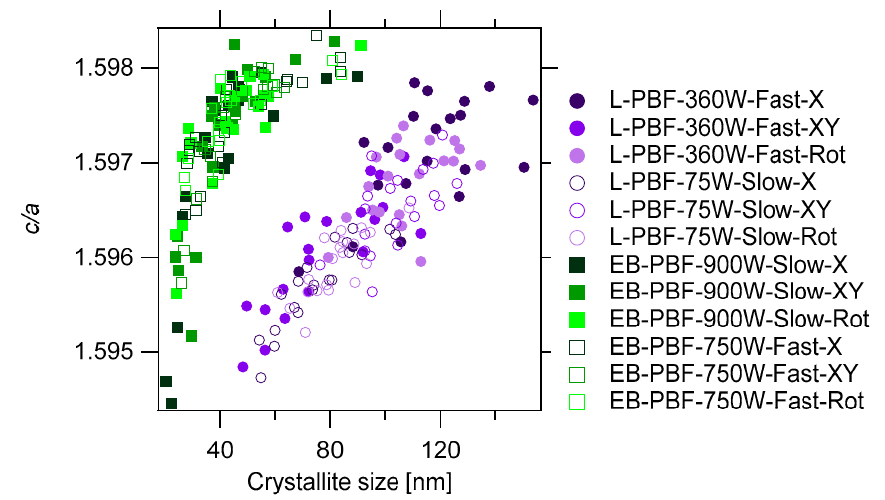
Figure 5. Crystallite size of the α or α ’ phase versus random lattice strain of the α or α ’ phase scatter plots for all L-PBF and EB-PBF parts. Random lattice strain in ( a ) the a -axis and ( b ) the c -axis directions. A correlation between the crystallite size and the random lattice strain, and the separation of the L-PBF and EB-PBF data points are seen.